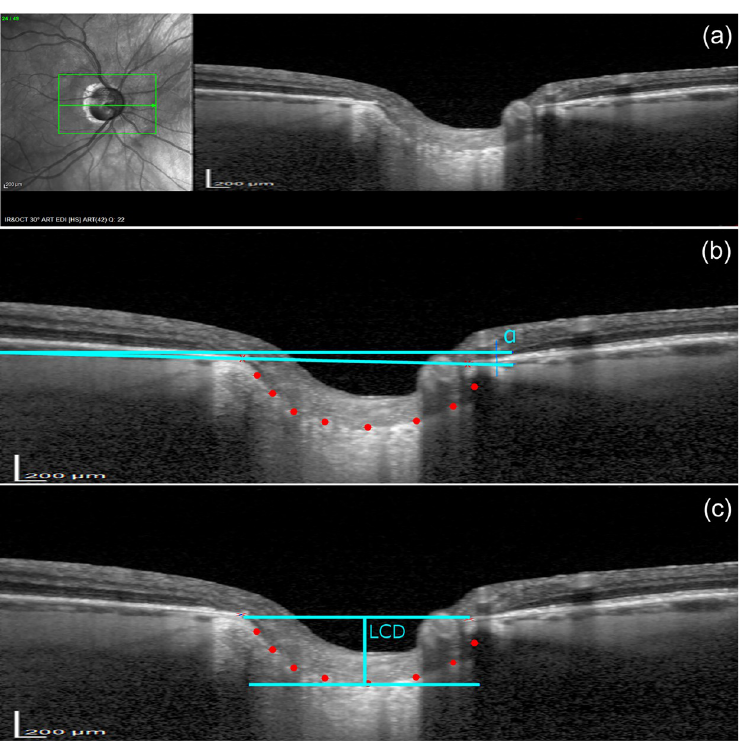
Fig 2. An example of infrared fundus photography and a B-scan image obtained at baseline and methods for determination of lamina cribrosa (LC). (a) An example of the acquired OCT image; (b) A reference line at an angle α to the horizontal line was set by connecting two points (red crosses) characterizing the Bruch’s membrane opening (BMO). Eight points describing the anterior LC surface (red dots) were manually placed using a specially designed graphic user interface; (c) An image rotated by α . The LC depth (LCD) was automatically calculated as the maximum perpendicular distance (corresponding to maximally depressed point) between the points of anterior LC surface and the BMO